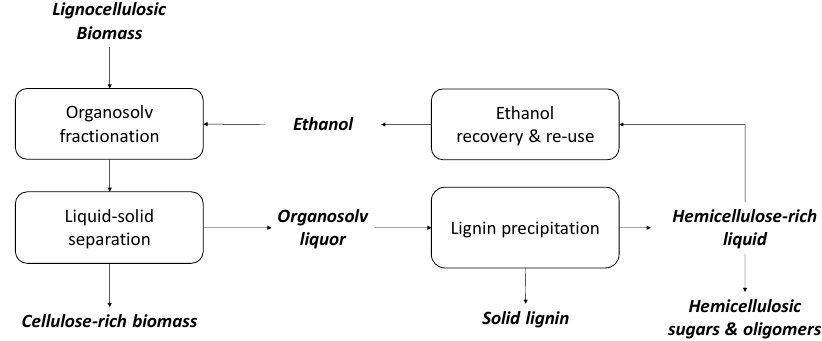
Figure 1. Process diagram of the ethanol organosolv fractionation.